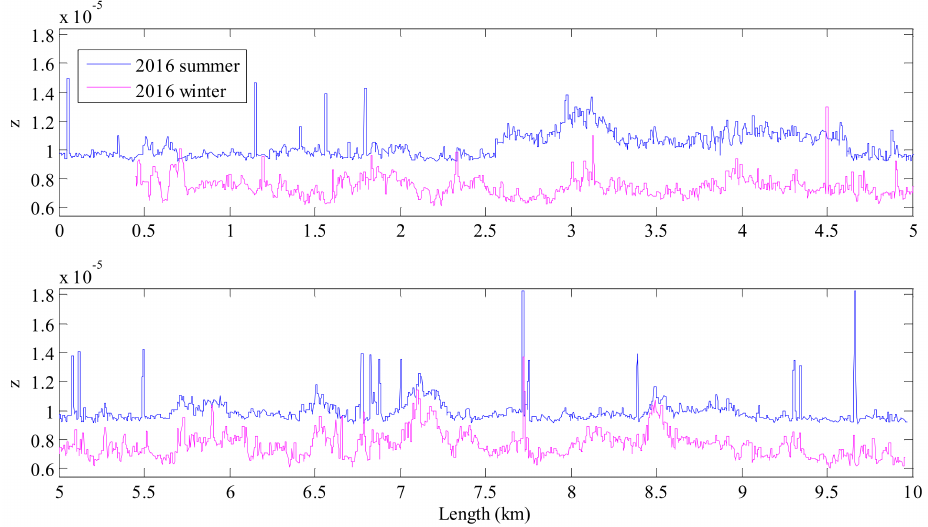
Figure 17. GPR parameter z , in the time domain, measured in January (winter) and in July (summer) of